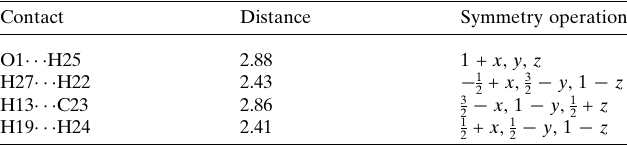
Table 3 Percentage contributions of interatomic contacts to the Hirshfeld surface for the title